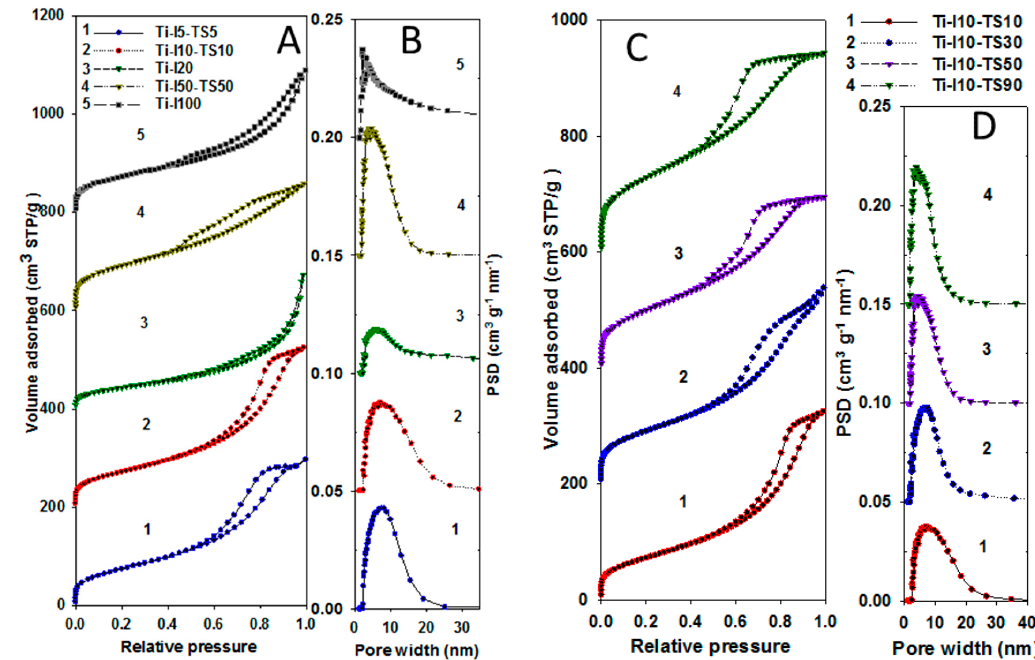
Figure 2. Left: ( A ): N 2 adsorption isotherms (left panel) and ( B ) the corresponding PSD curves for the Ti-Ix-TSx (x = 5, 10, 50) and Ti-Ix (x = 20, 100) samples. Right: ( C ): N 2 adsorption isotherms (left panel) and ( D ) the corresponding PSD curves for the Ti-I10-TSx samples thermally treated at 350 °C (All isotherms and PSD are shifted by a multiple of 200 cm 3 STP/g and of 0.05 cm 3 g − 1 nm − 1 , respectively).